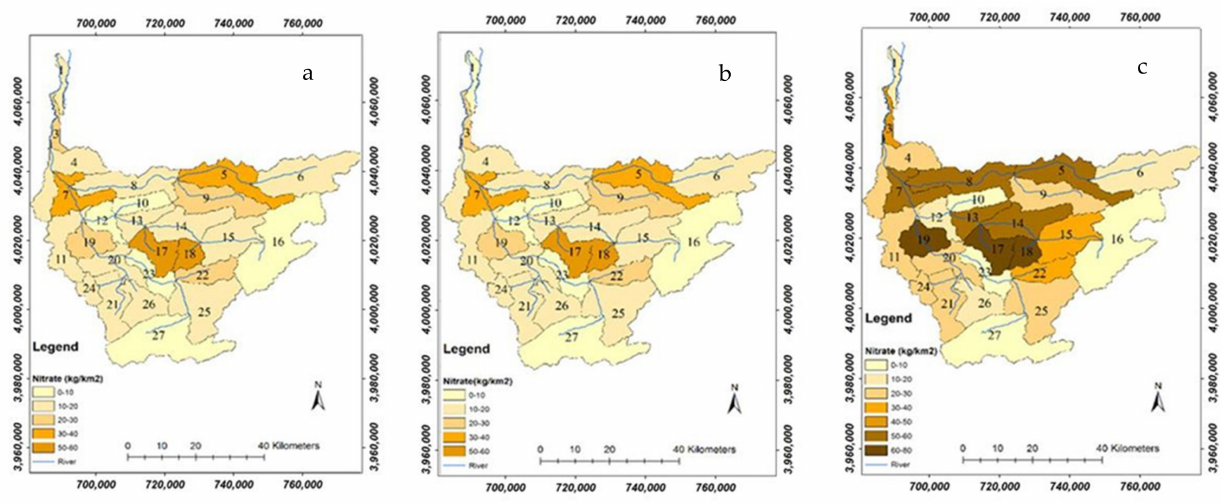
Figure 6. Nitrate Loads for: ( a ) 2010, ( b ) continuity scenario, and ( c ) limitation and conservation scenario from left to